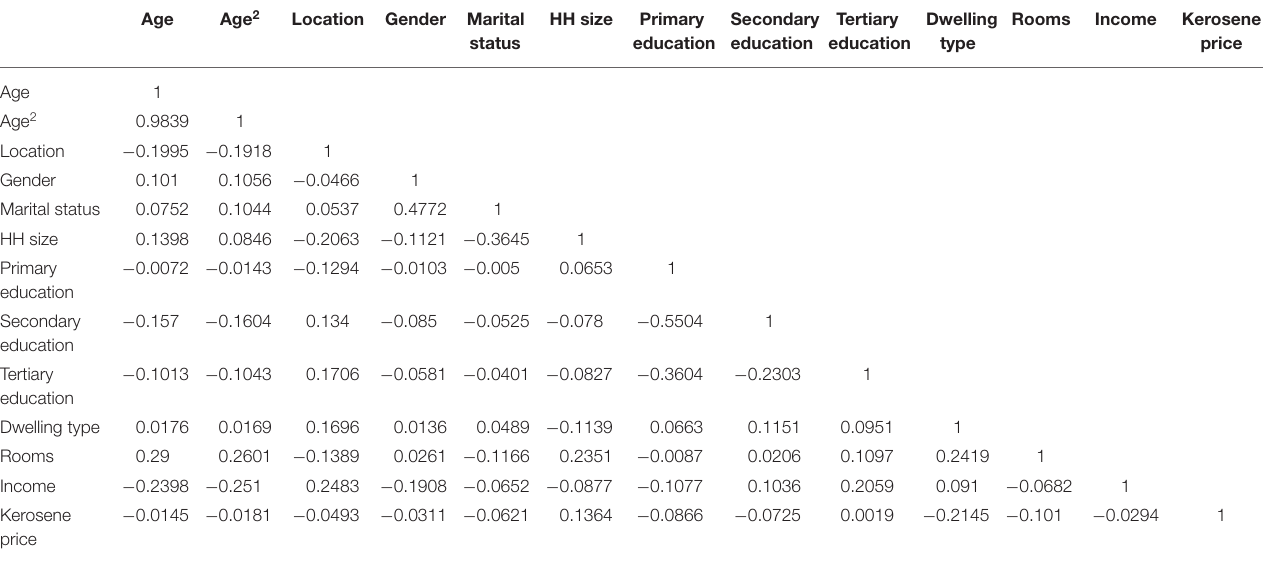
TABLE A1 | Correlation matrix of independent